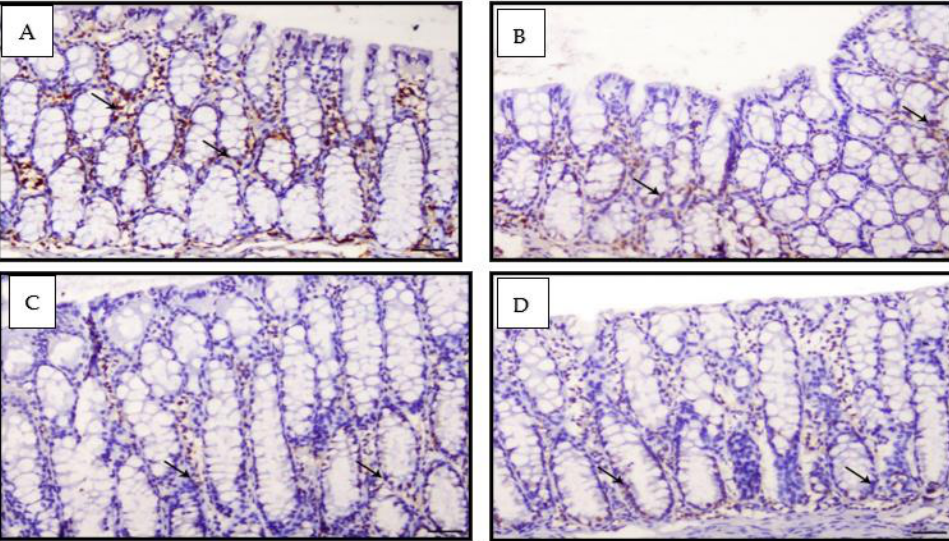
Figure 9. Photomicrographs of colon sections of mice stained IHC with PCNA; ( A ): Colon section of Group I animals showing mild expression of PCNA within the intestinal crypts (arrows), PCNA IHC, ×200, bar = 50 μ m; ( B , C ): Colon section from Group II animals showing mild expression of PCNA within the intestinal crypts (arrows), PCNA IH, ×200, bar = 50 μ m; ( D ) Colon section from Group III animals showing mild expression of PCNA within the intestinal crypts (arrows), PCNA IHC, ×200, bar = 50 μ m.